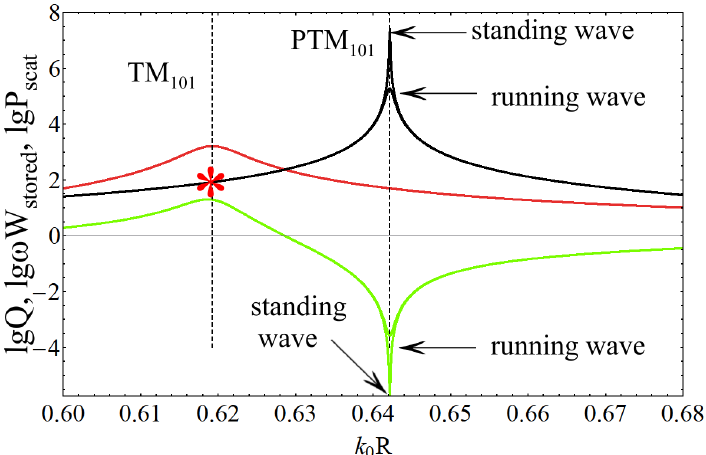
Figure 5. The dependence of scattered power P scat (green), stored energy W stored (red), and generalized radiation quality factor Q = ω W stored /P scat (black) on the size parameter of a sphere obtained within the Comsol simulation . TM excitation (13), α = atan (2) , ε = 50 (Bi 2 Te 3 ). The asterisk on the red curve shows the Q factor value of the TM 101 mode.